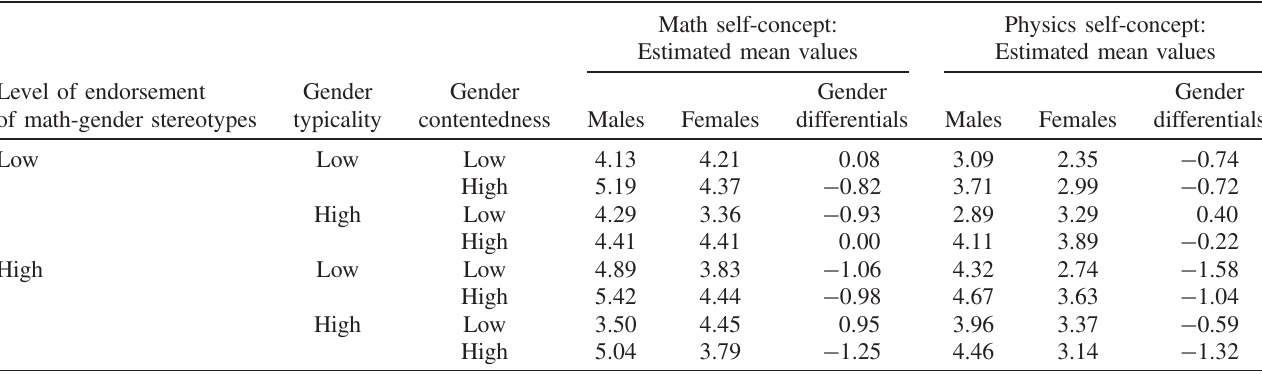
TABLE IV. Gender differentials in math and physics self-concepts based on MANCOVA analyses.